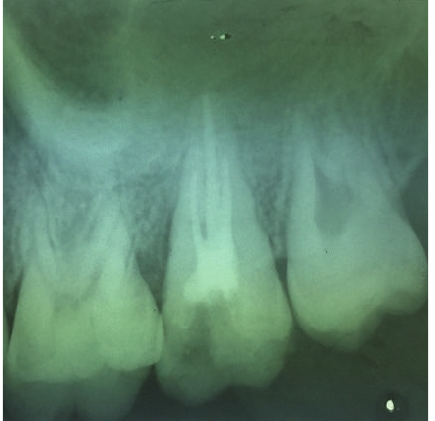
Figure 11: Postobturation radiograph with respect to